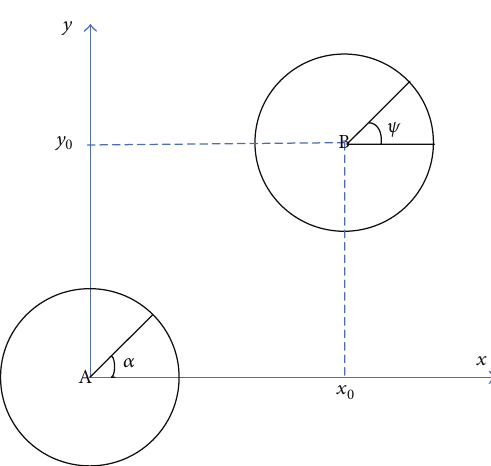
Figure 2: Diagram of the circular polarization antenna array which contains two microstrip